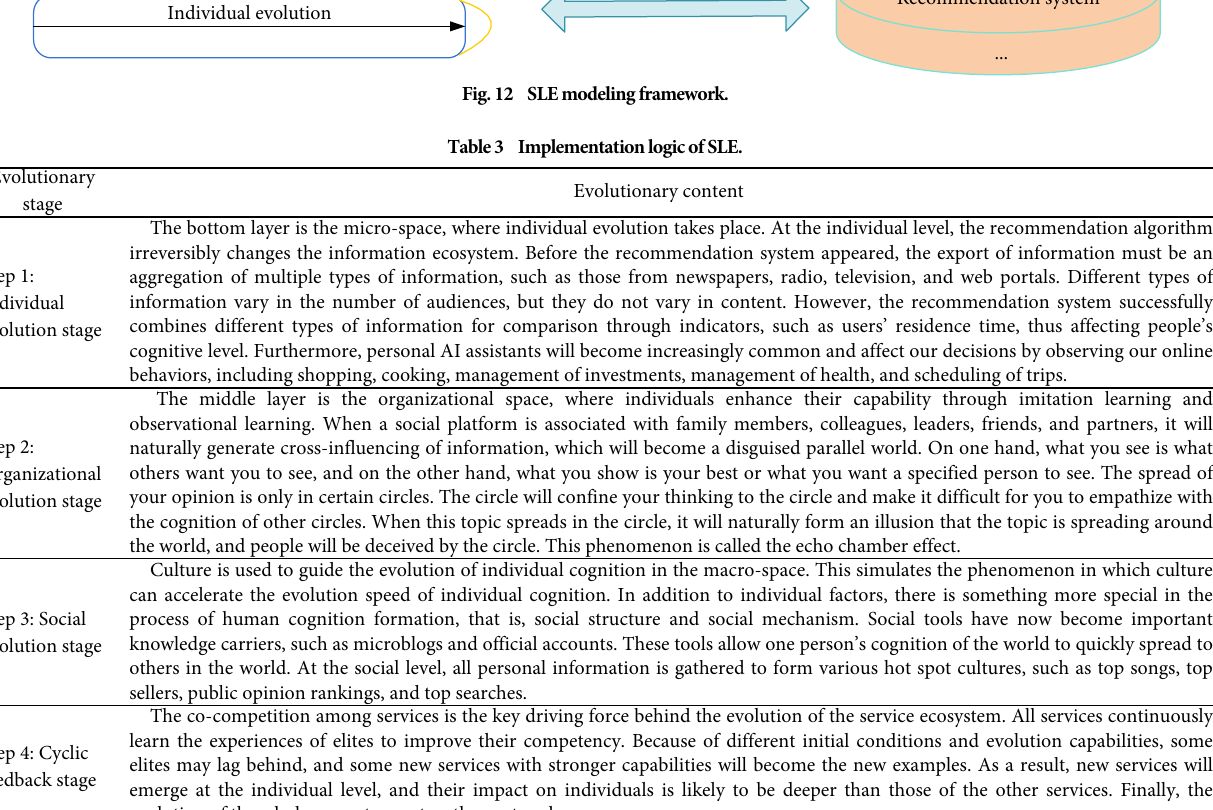
Fig. 12 SLE modeling framework. Table 3 Implementation logic of